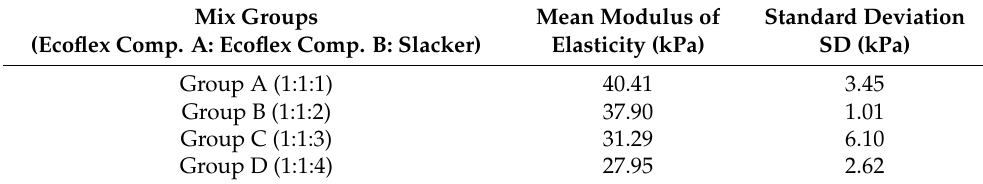
Table 2. Mean modulus of elasticity and standard deviation of the tested samples (Ecoflex A:B:Slacker). Mix